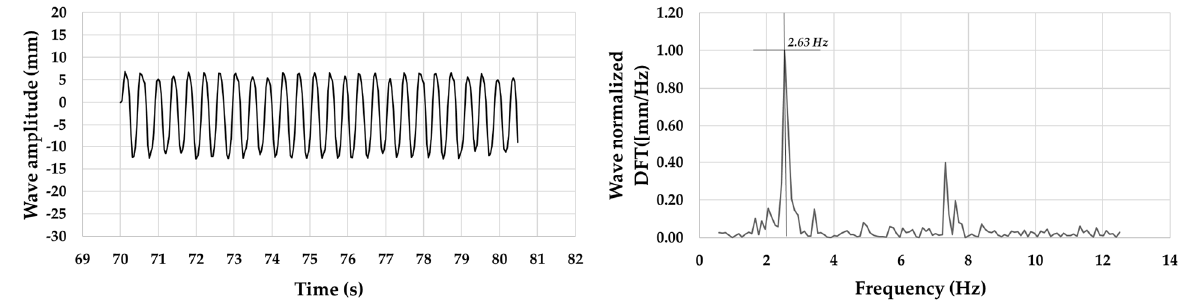
Figure 7. Wave amplitude and normalized DFT in artificial channel.